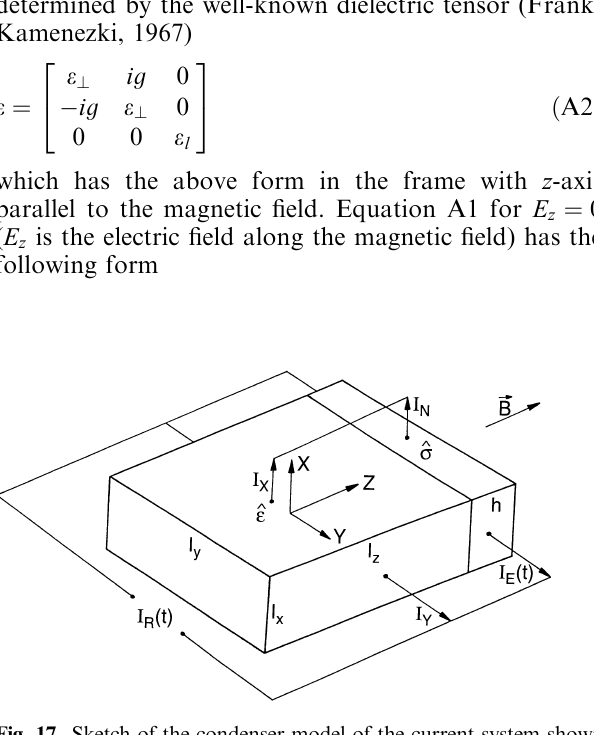
Fig. 17. Sketch of the condenser model of the current system shown in